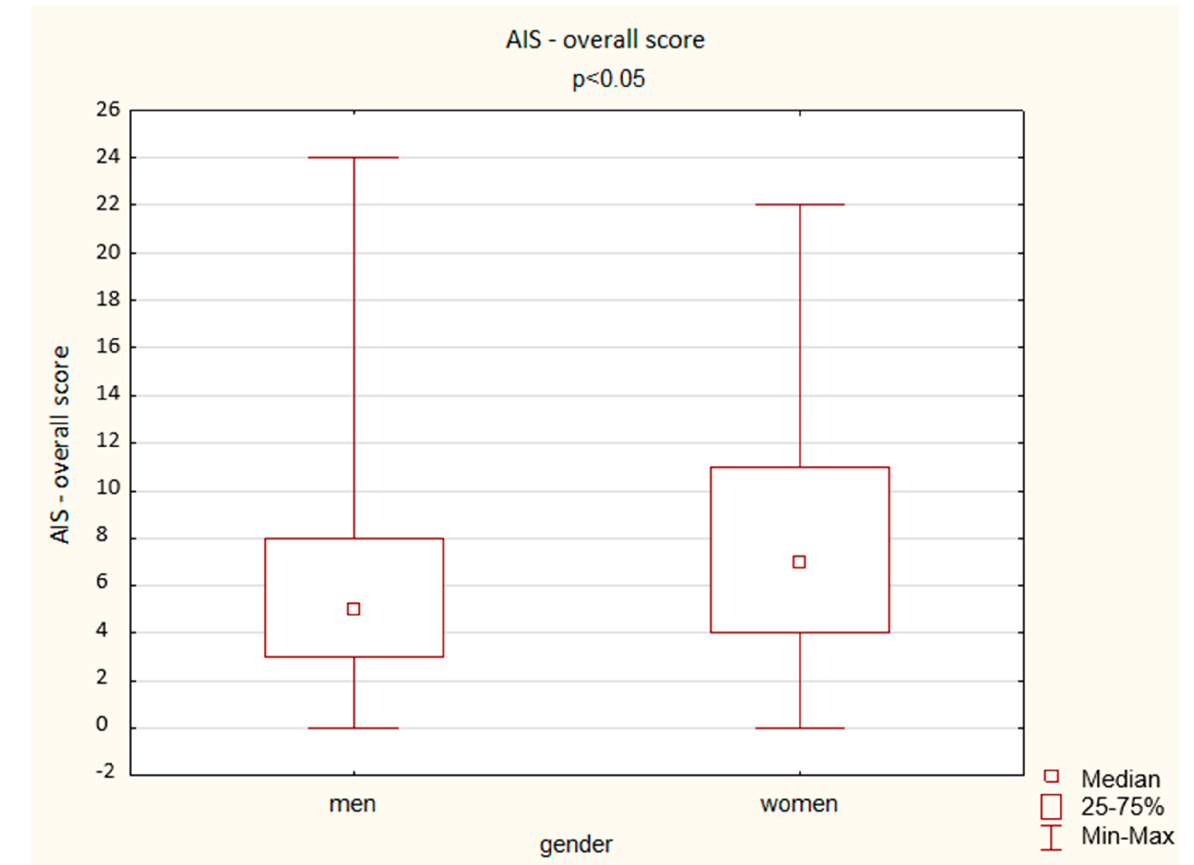
Figure 7. Patient results in the AIS—overall score (Mann–Whitney U test). Among the hospitalized patients due to contracted COVID-19 who completed fully the AIS (n = 86), the results presented themselves as follows: 45.3% (n = 39) of the patients did not show any sleep disturbances, and 27.9% (n = 24) of the patients had a result indicating sleep disturbances (>5 points on the scale), while 26.7% (n = 23) of the patients had a result indicating insomnia (>10 points on the